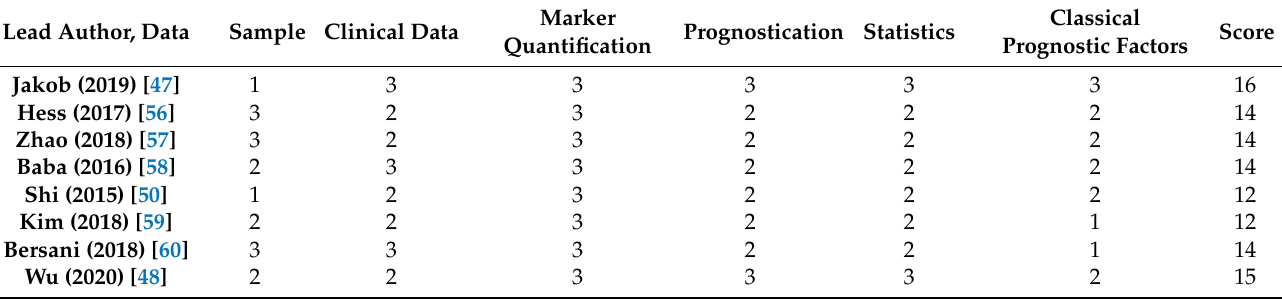
Table 2. Assessment of risk of bias within the studies. with scores 8 to 10 = low quality, 11 to 14 = intermediate quality, and 15 to 18 = high